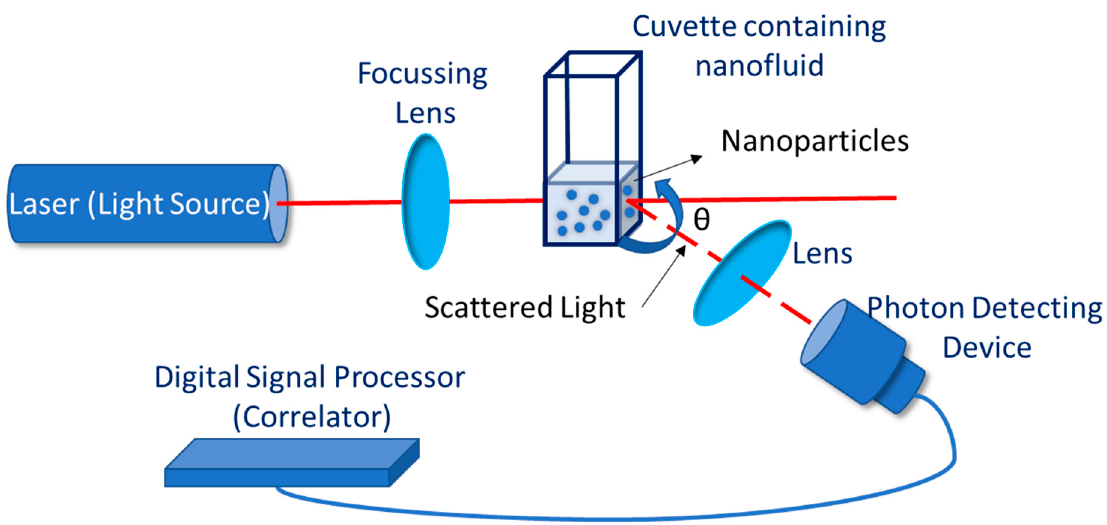
Figure 6. Scheme of dynamic light scattering measurement.